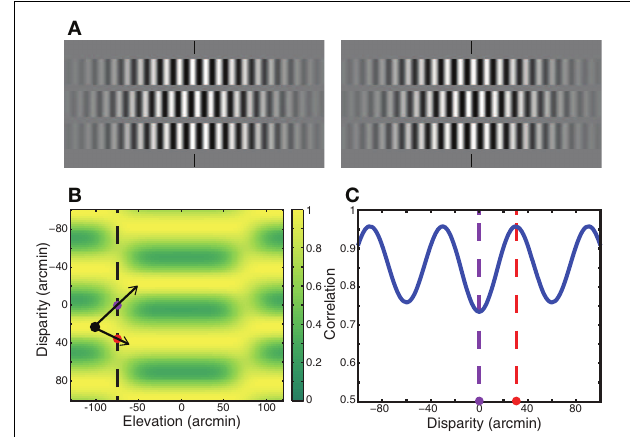
FIGURE 8 | Analysis of Zhang et al. (2001). (A) The stereogram in the Zhang et al. study. A central strip composed of a sinewave grating is surrounded by flanking strips with gratings of the same frequency. Absolute-disparity minimization would lead to a percept in which the central strip is in front of the plane of fixation and the flanking strips are behind. Relative-disparity minimization would produce a percept in which the central and flanking strips are both in front of or both behind the fixation plane. Cross-fuse to see the stereoscopic percept derived from this stimulus. Most viewers perceive both the central and flanking strips in front of the fixation plane, the percept predicted by relative-disparity minimization. (B) Output of local cross-correlation conducted on this stimulus. The abscissa represents vertical position in the stimulus. The ordinate represents horizontal disparity; positive disparities are near and negative are far. The black dot represents one of the solutions for the flanking strip. The red dot is positioned in the transition between the flanking strip and a solution for the central strip that would minimize relative disparity. The purple dot is positioned in the transition between the flanking strip and a solution for the central strip that would minimize absolute disparity. (C) Correlation as a function of disparity along the vertical dashed line in panel (B) . Correlation ranges from 0.5 to 1. The purple dashed line represents the solution toward absolute-disparity minimization. The red dashed line represents the solution toward relative-disparity minimization. The correlation is higher in the region indicated by the red dot than in the region indicated by the purple dot. Thus, cross-correlation favors relative-disparity minimization rather than absolute-disparity